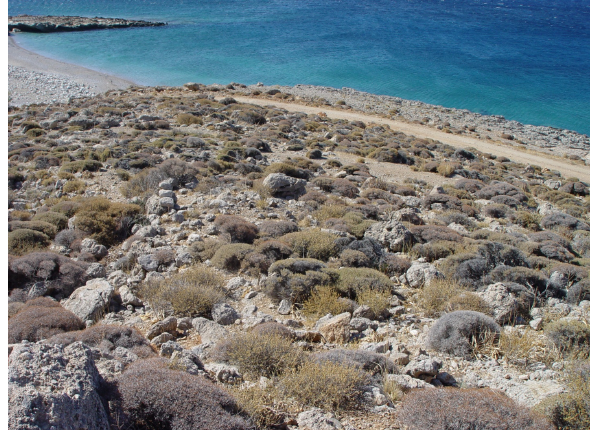
Figure 1. The photo of the site of Livari Cheromylia (view from the north; photo by the author).